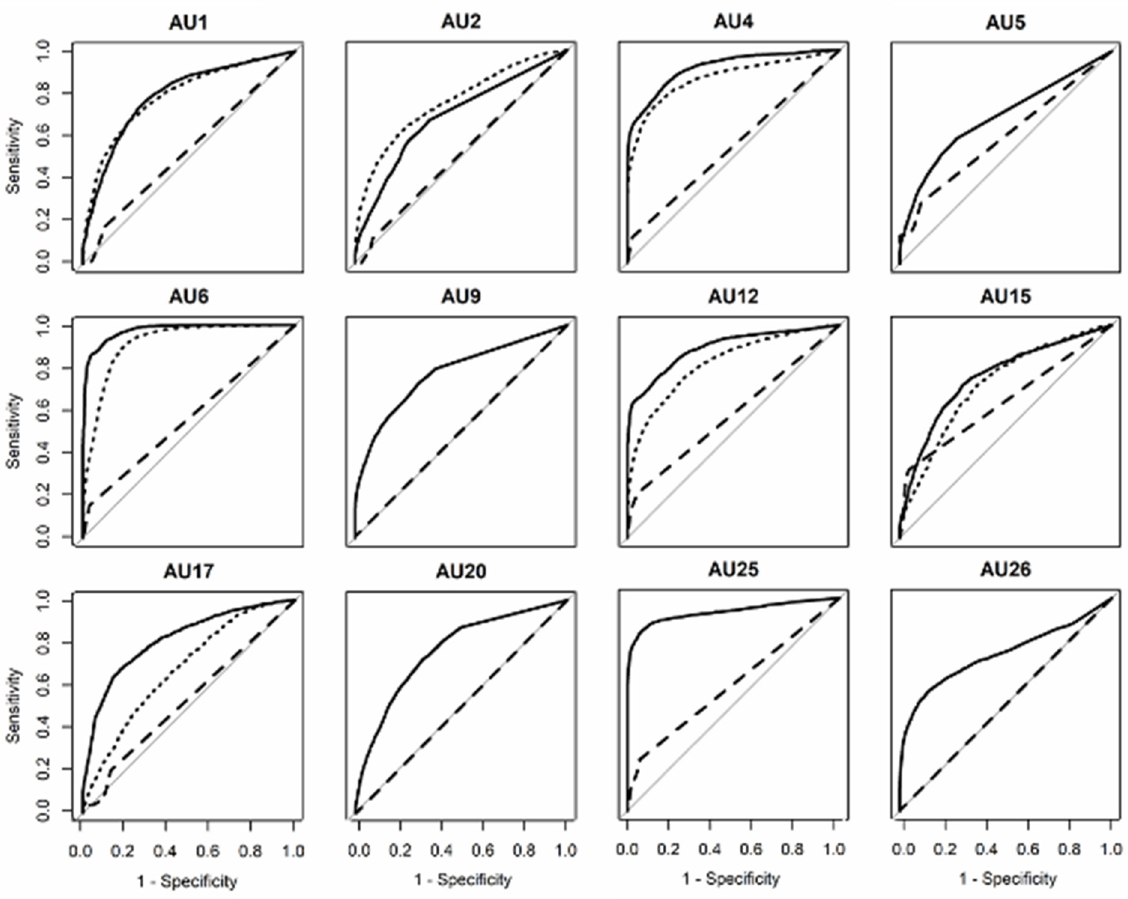
Figure 4. Receiver operating characteristic curves for each action unit in the DISFA+ (posed) database obtained by the three machines. Solid line represents OpenFace, dashed line represents FaceReader, and dotted line represents AFAR. The diagonal line indicates random performance.